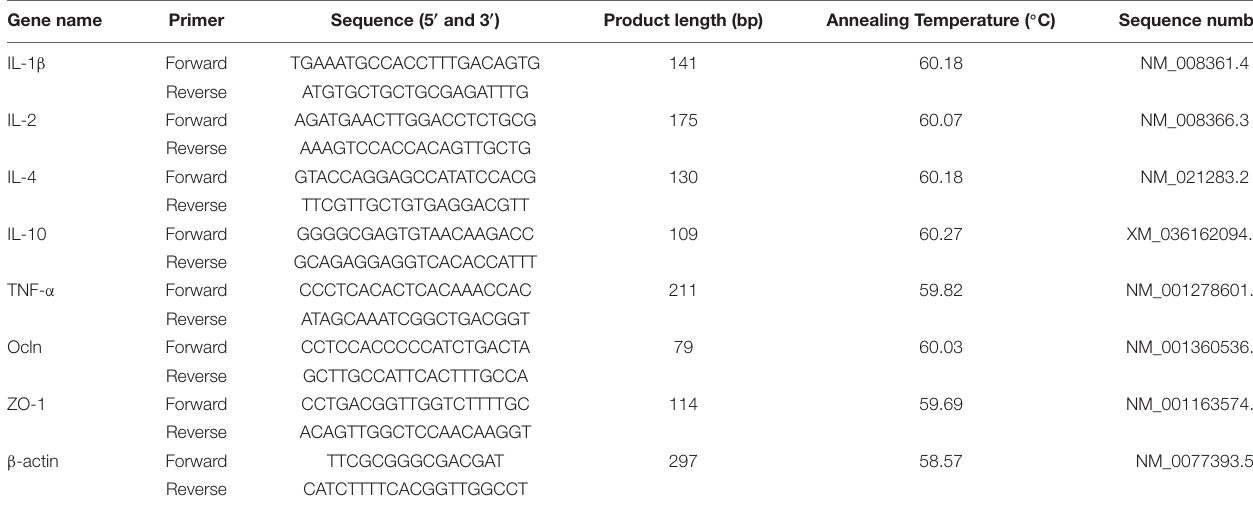
TABLE 2 | Primers used for the real-time PCR